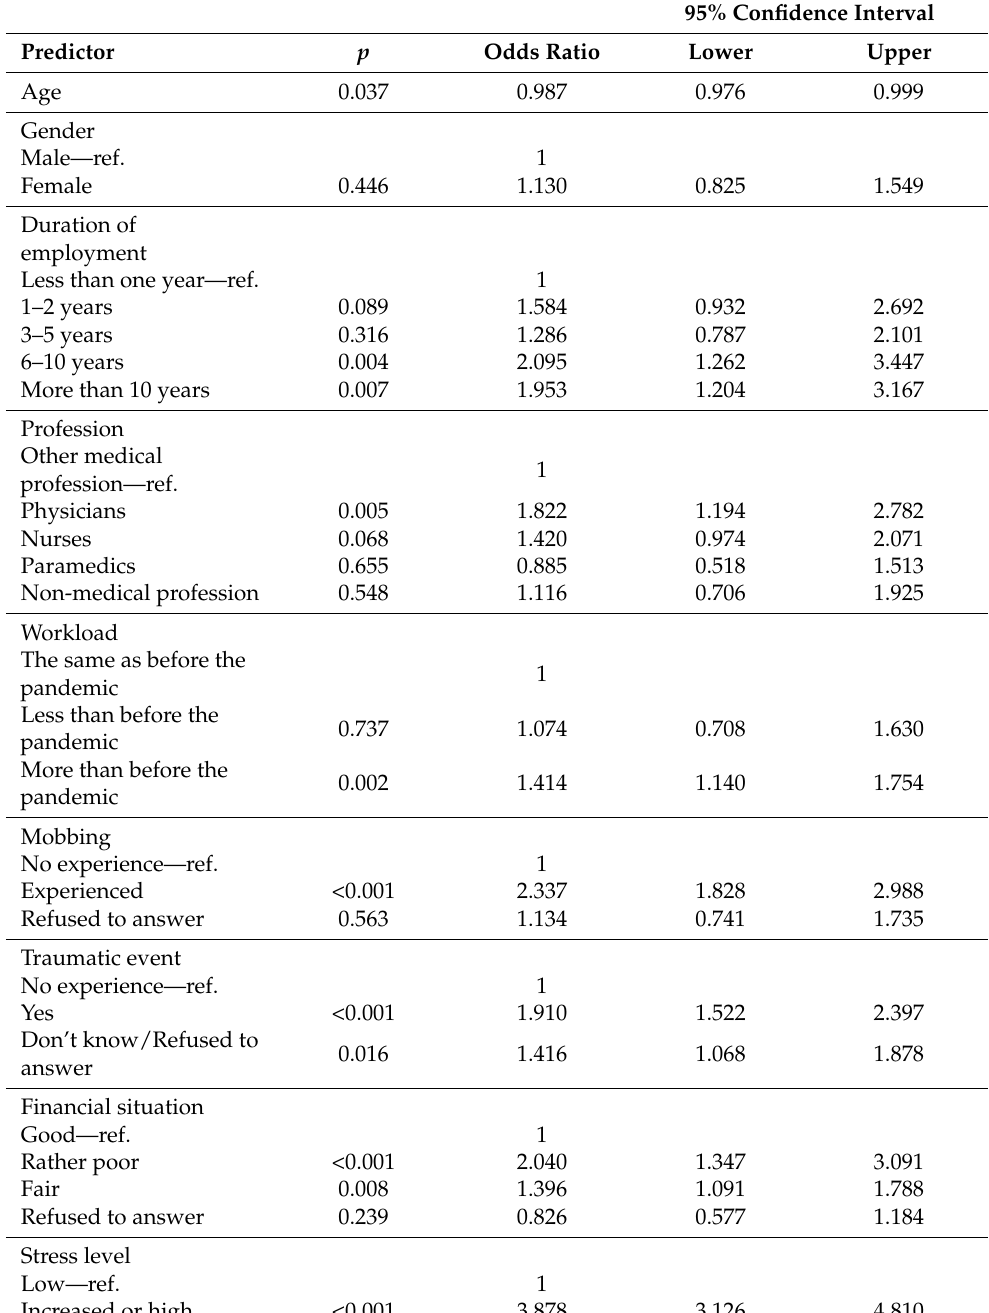
Table 6. Final multivariate logistic regression model for the risk of burnout (N =